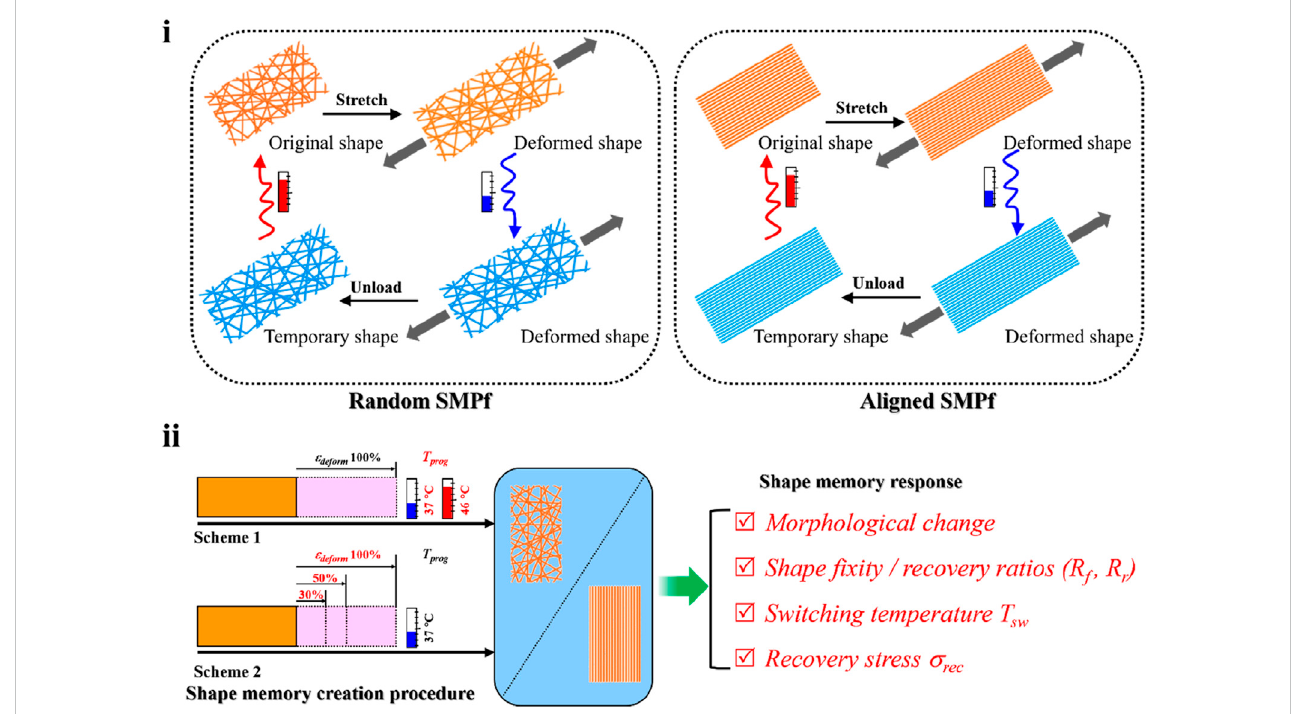
FIGURE 1 Study design overview. (i) Typical shape memory cycles including the SMCP and thermal-triggered shape recovery for the random (left) and aligned (right) fi brous mats. (ii) Comparative study on shape-memory responses including morphology change, shape fi xity, recovery ratios (i.e., R f and R r ), switching temperature T sw , and recovery stress σ rec regulated by two sets of programming schemes, namely, 1) altering the programming temperature T prog (i.e., 37 ° C and 46 ° C) at the stretch deforming strain ε deform of 100% and 2) altering ε deform (i.e., 30%, 50%, and 100%) at T prog of 37 °